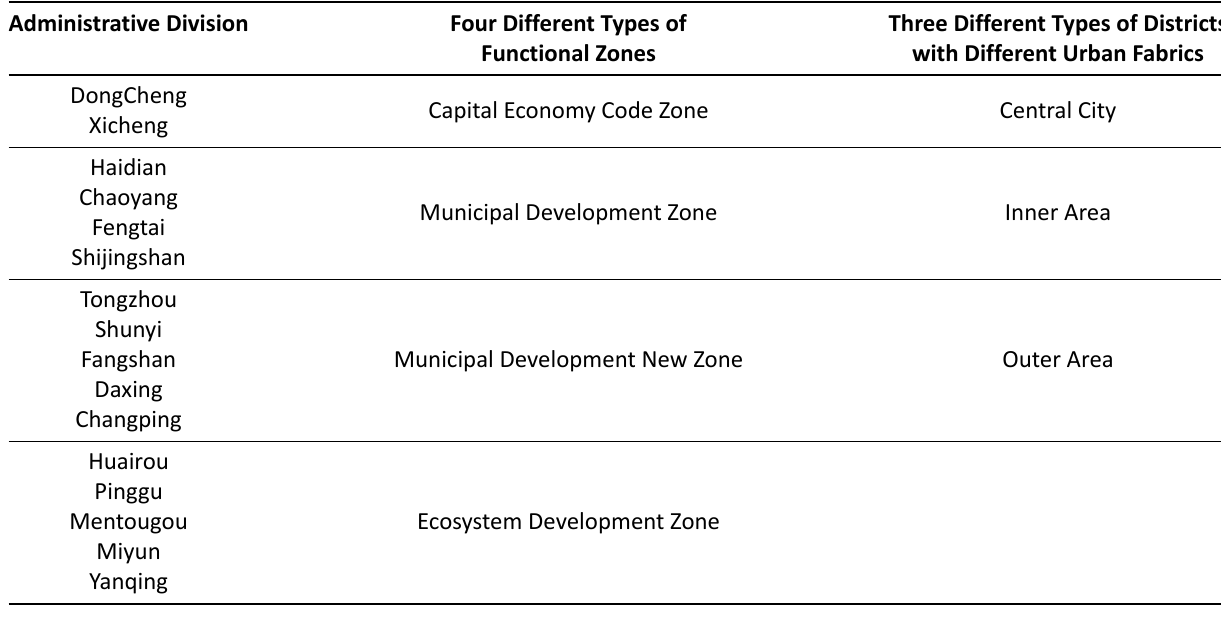
Table 1. Different categories of districts in Beijing. Source: Compiled based on data provided by the Beijing Municipal Bureau of Statistics (BJMBS, 2016).